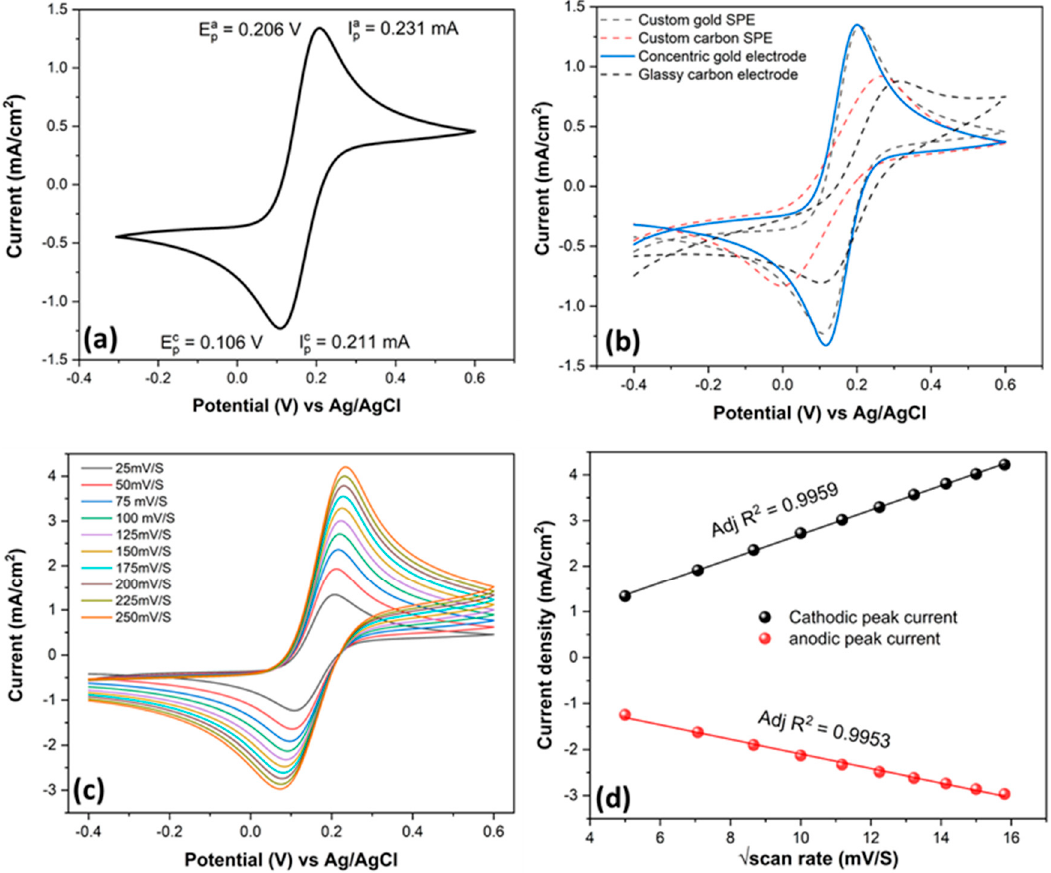
Figure 2. ( a ) Cyclic voltammetry (CV) result of SENCE in 10 mM Fe(II) / Fe(III) diluted in 0.1 M KCl. ( b ) CV comparison of fabricated electrode and commercial electrode available on the market showing the superior result for SENCE. ( c) Scan rate study using SENCE platform. ( d ) Peak current plotted with scan rate to validate Randles–Sevcik equation, showing linearity in both cathodic and anodic peak current.